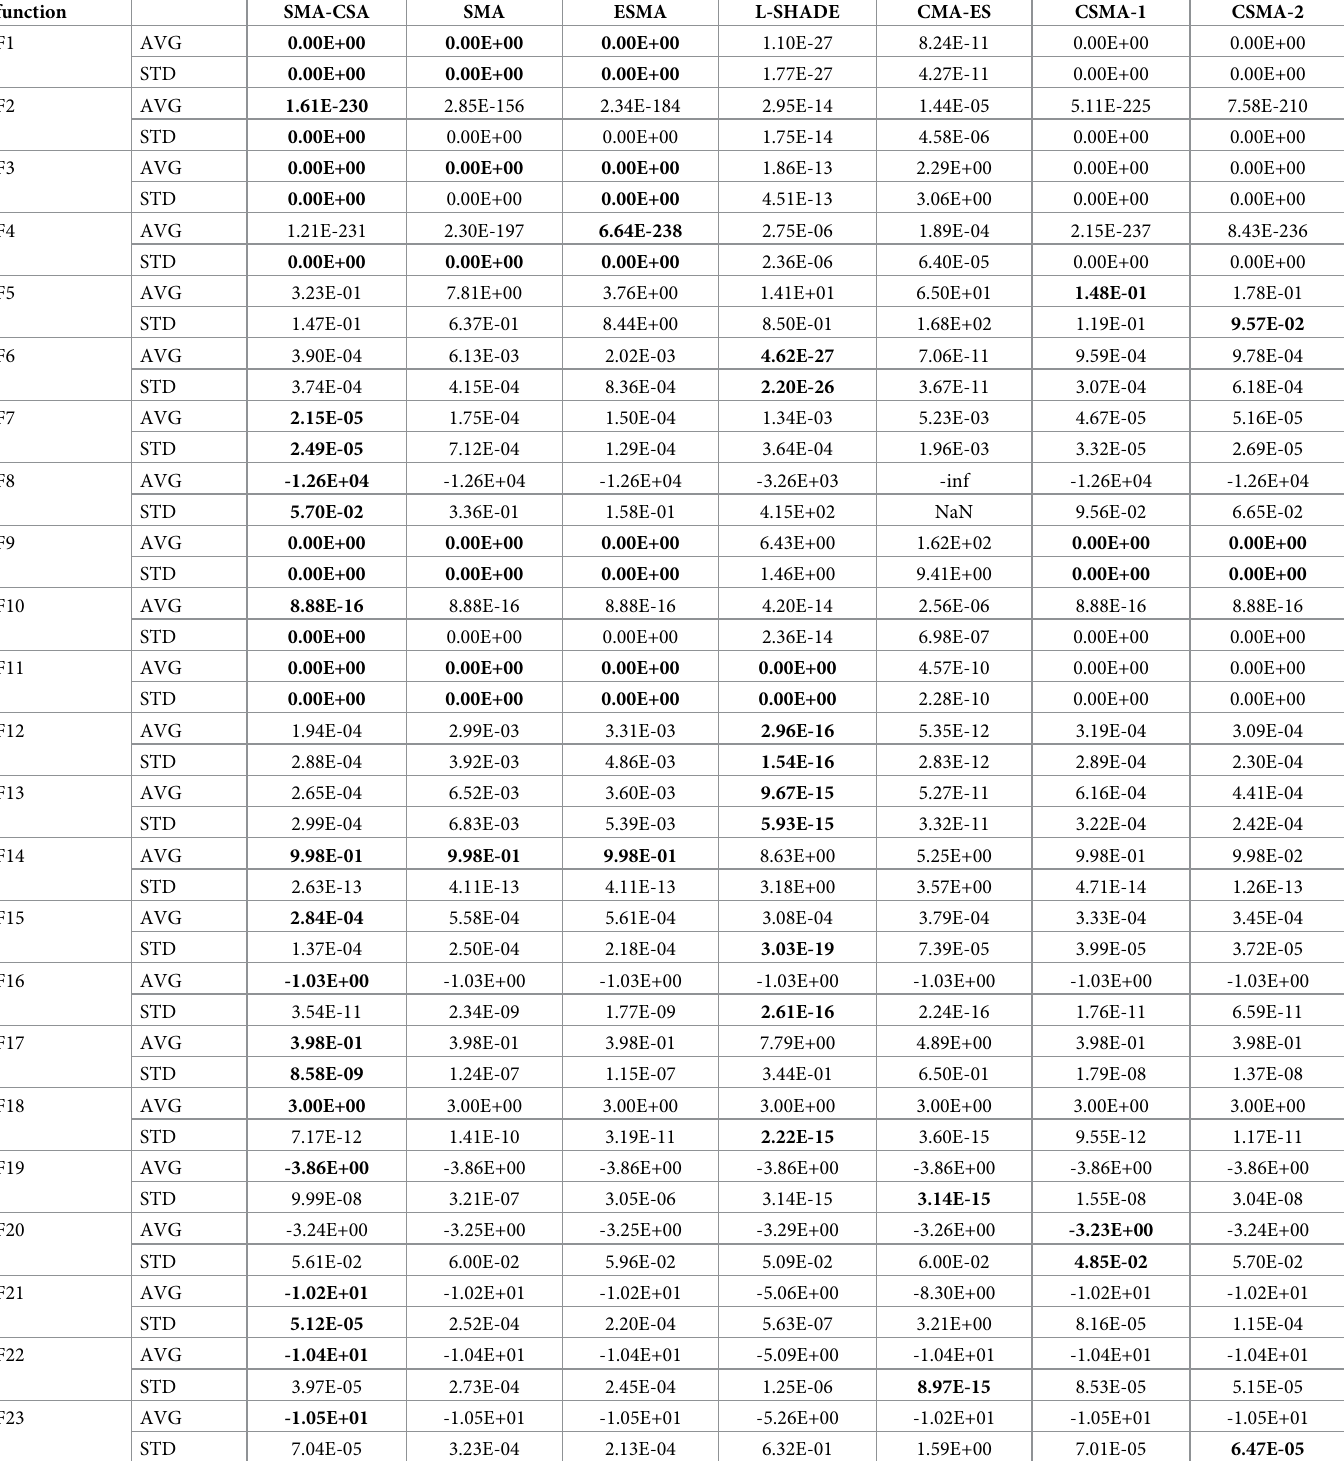
Table 7. Comparison of benchmark function results between improved